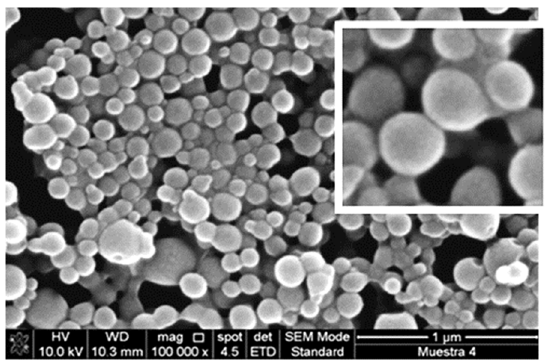
Figure 1. Nanoparticles of zein/resveratrol. Adapted with permission from [95]. Copyright 2015 American Chemical Society.